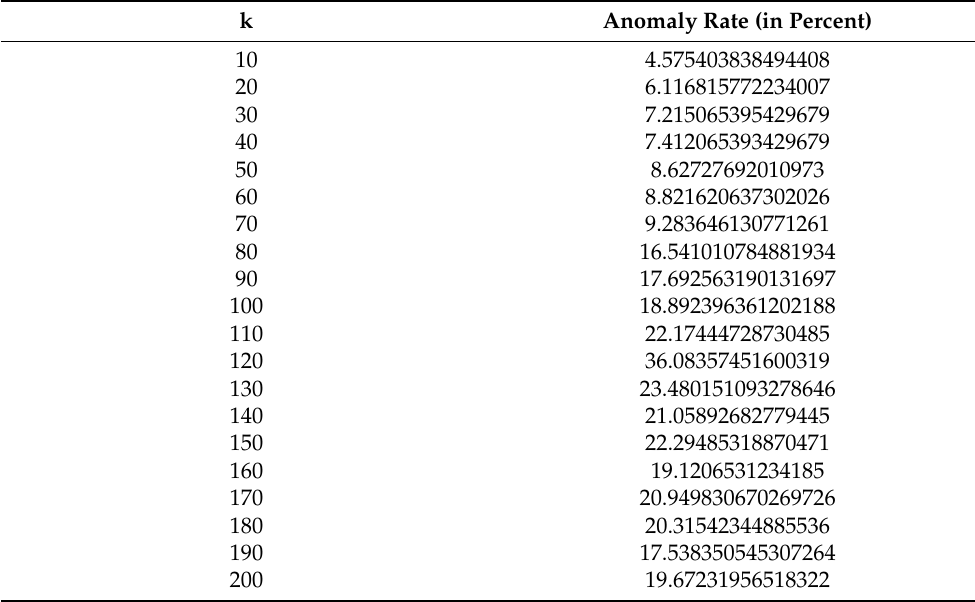
Table 4. Anomaly rates after